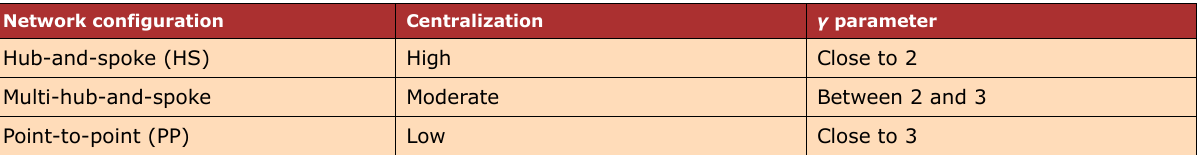
Table 2. Relationship between network configurations and network